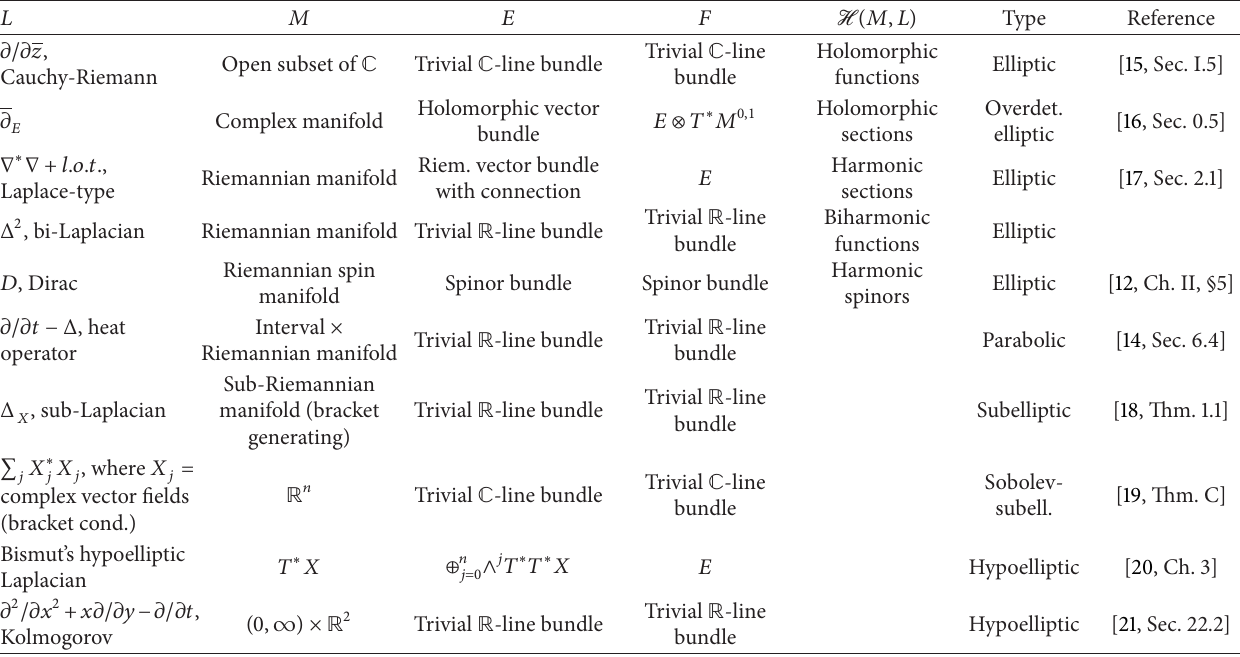
Table 1: Examples of hypoelliptic differential